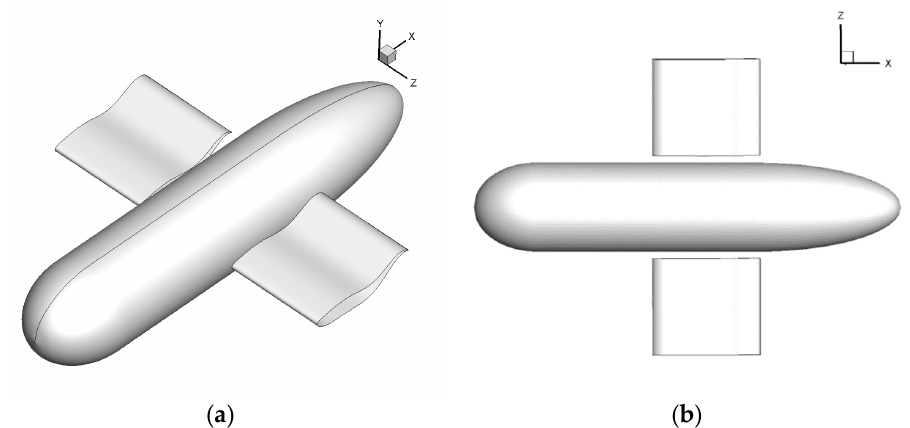
Figure1. Currentbio-inspiredautonomousunderwaterglider(AUG)modelwithactivetwinundulatory Figure 1. Current bio-inspired autonomous underwater glider (AUG) model with active twin wings. ( a ) Perspective view; and ( b ) top undulatory wings. ( a ) Perspective view; and ( b ) top view.